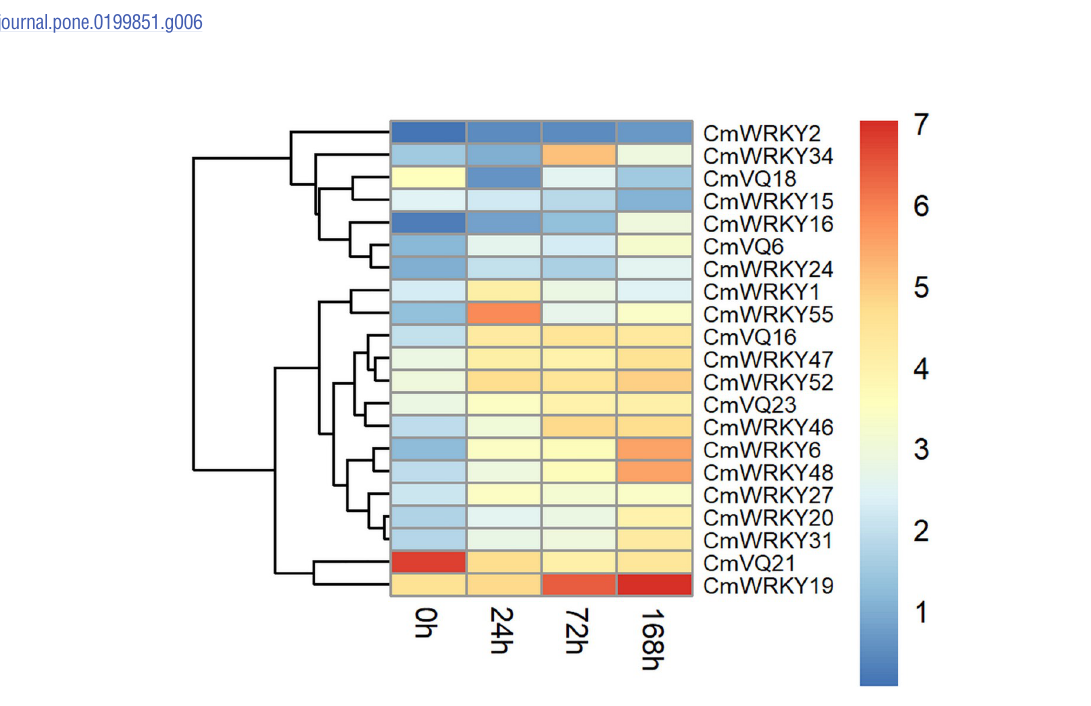
PLOS ONE | https://doi.org/10.1371/journal.pone.0199851 December27,